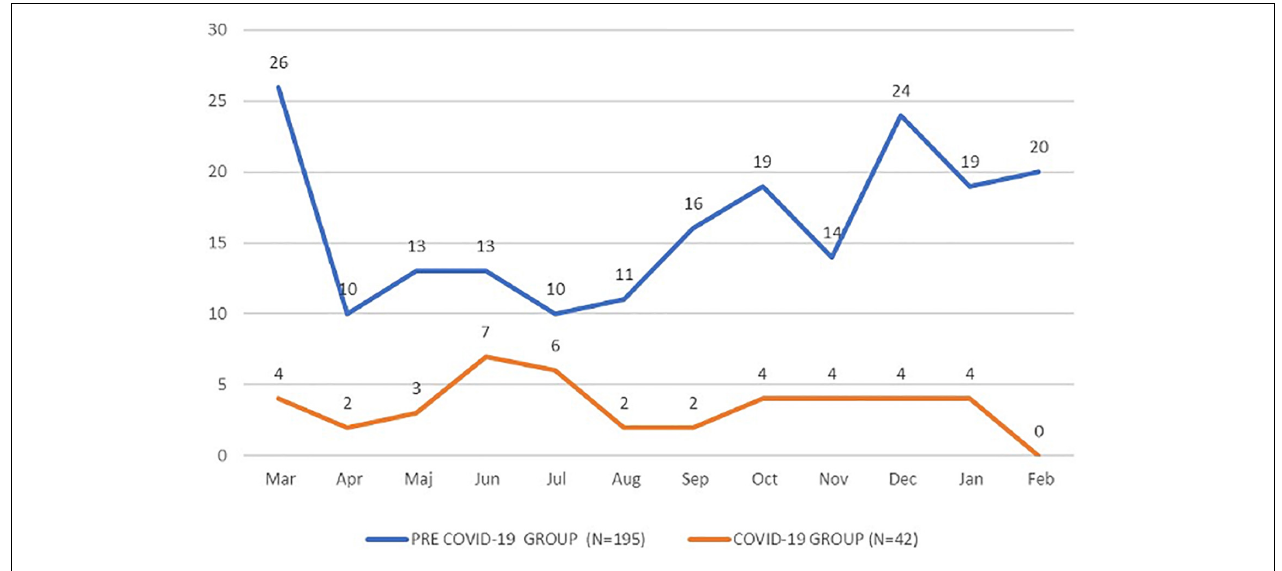
FIGURE 1 | Number of emergency cases per month during the study period.